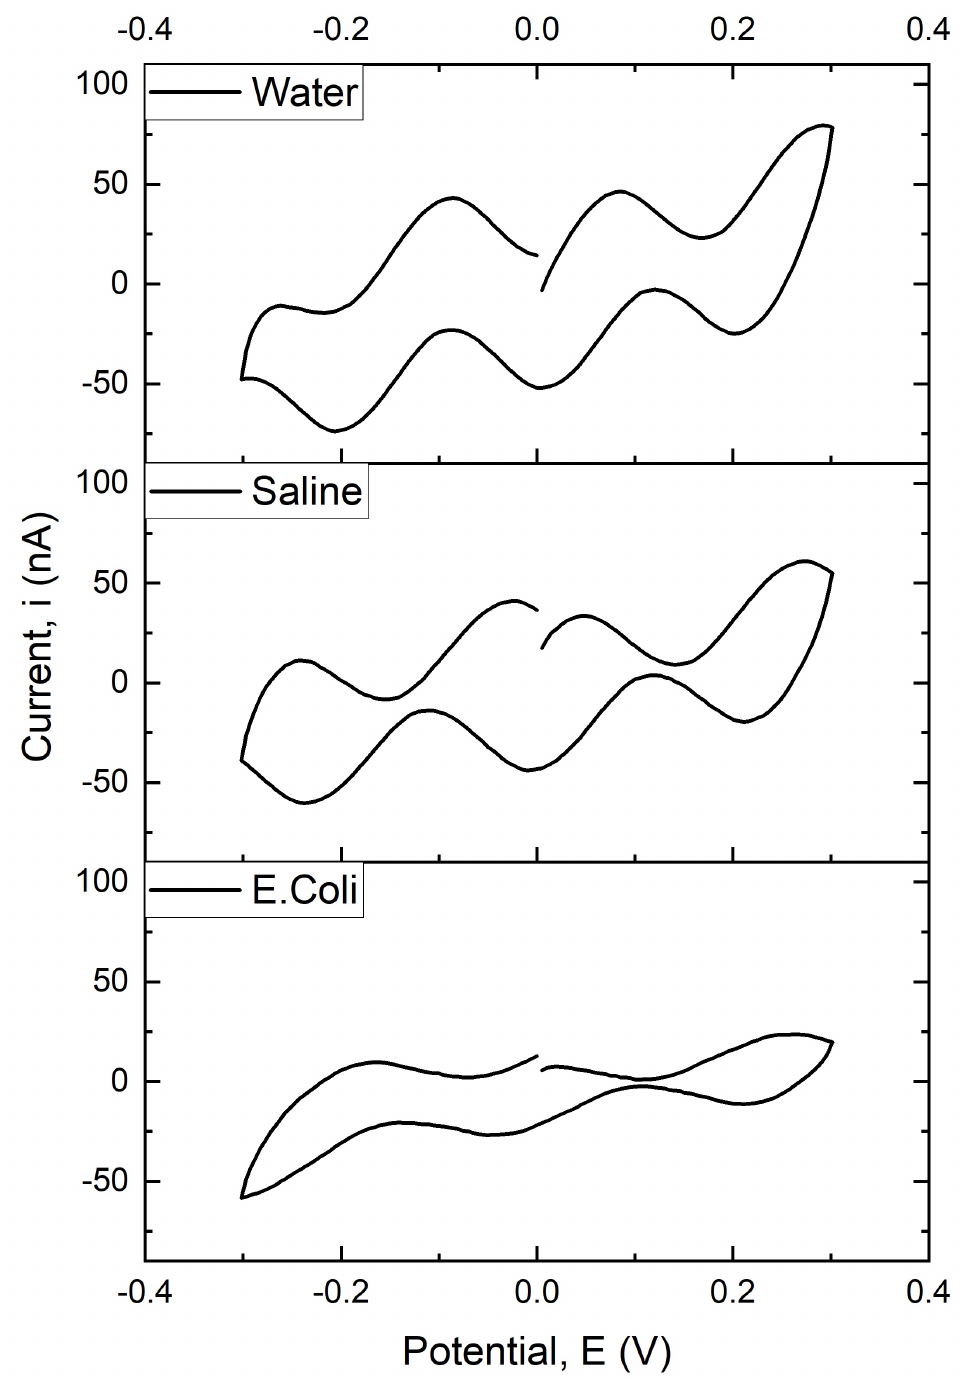
Figure 3. Cyclic voltammogram (CV) of G-IDECONAU10 electrode using three different